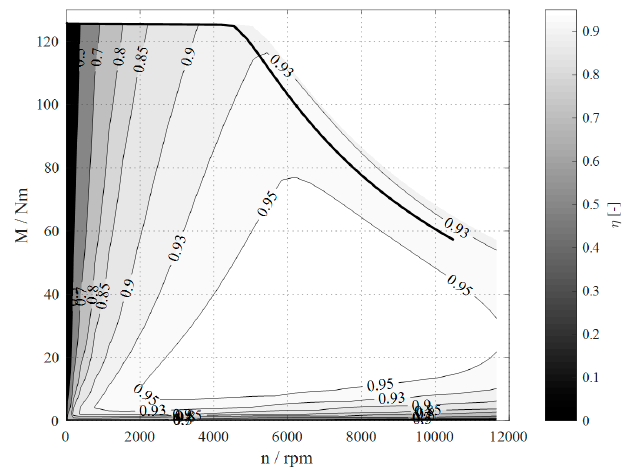
Figure 4. Map of efficiency curves of the electric drives used for simulation.